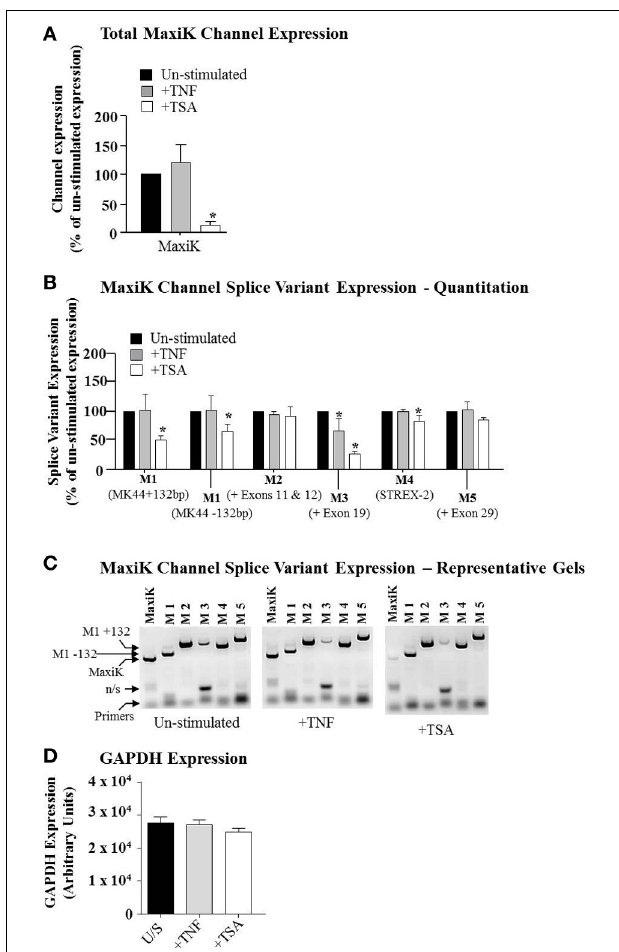
FIGURE 3 | The expression of the MaxiK channel and splice variants in primary myometrial cell cultures. Primary myometrial cell cultures were stimulated with 10ng/ml TNF for 1h, 100ng/ml TSA for 24h or left un-stimulated. RNA was extracted, reverse transcribed and amplified using channel and splice variant specific primers. Manual quantification of the relative band intensities were used to quantify the level of expression and this was expressed as a percentage of the un-stimulated expression. (A) TNF had no significant effect whilst TSA significantly reduced the expression of the MaxiK channel ( ∗ p < 0 . 05). (B) Primary Myometrial cell cultures express a range of MaxiK splice variants, TNF had no effect on splice variant expression and TSA significantly reduced the expression of the MK44 splice variant ( ∗ p < 0 . 05). (C) Representative gel of the RT-PCR products. (D) Neither TNF nor TSA influenced the expression of